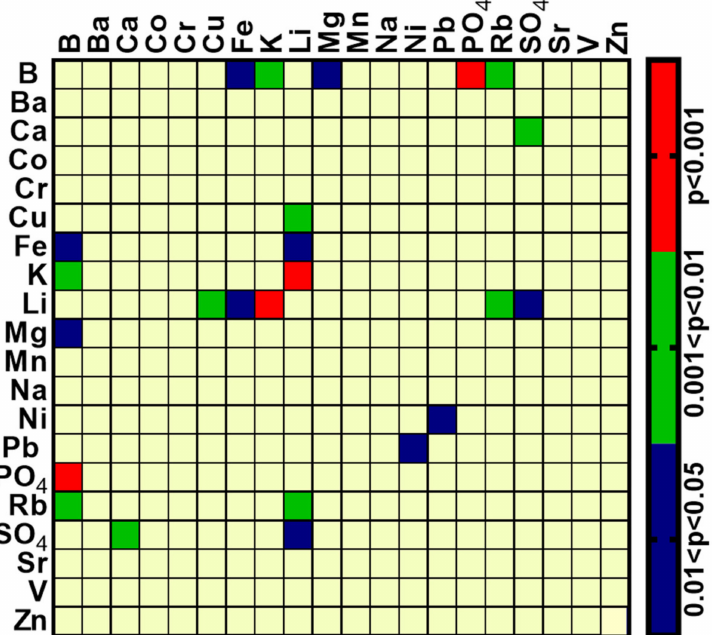
Figure 1. Heat map of the comparison of Spearman correlation coefficients (rs) of element concentra- tions between serum samples of BD patients before and after treatment. The rs were computed for all pairwise comparisons, separately for the samples before and after treatment. The two-tail statistical significance of the difference between the rs of the two groups for each pair of elements was tested, as described in the results section; only those elements statistically different are shown, grouped according to the scale to the